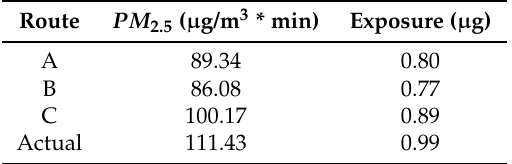
Table 6. Total PM 2.5 and Exposure Values of the Different